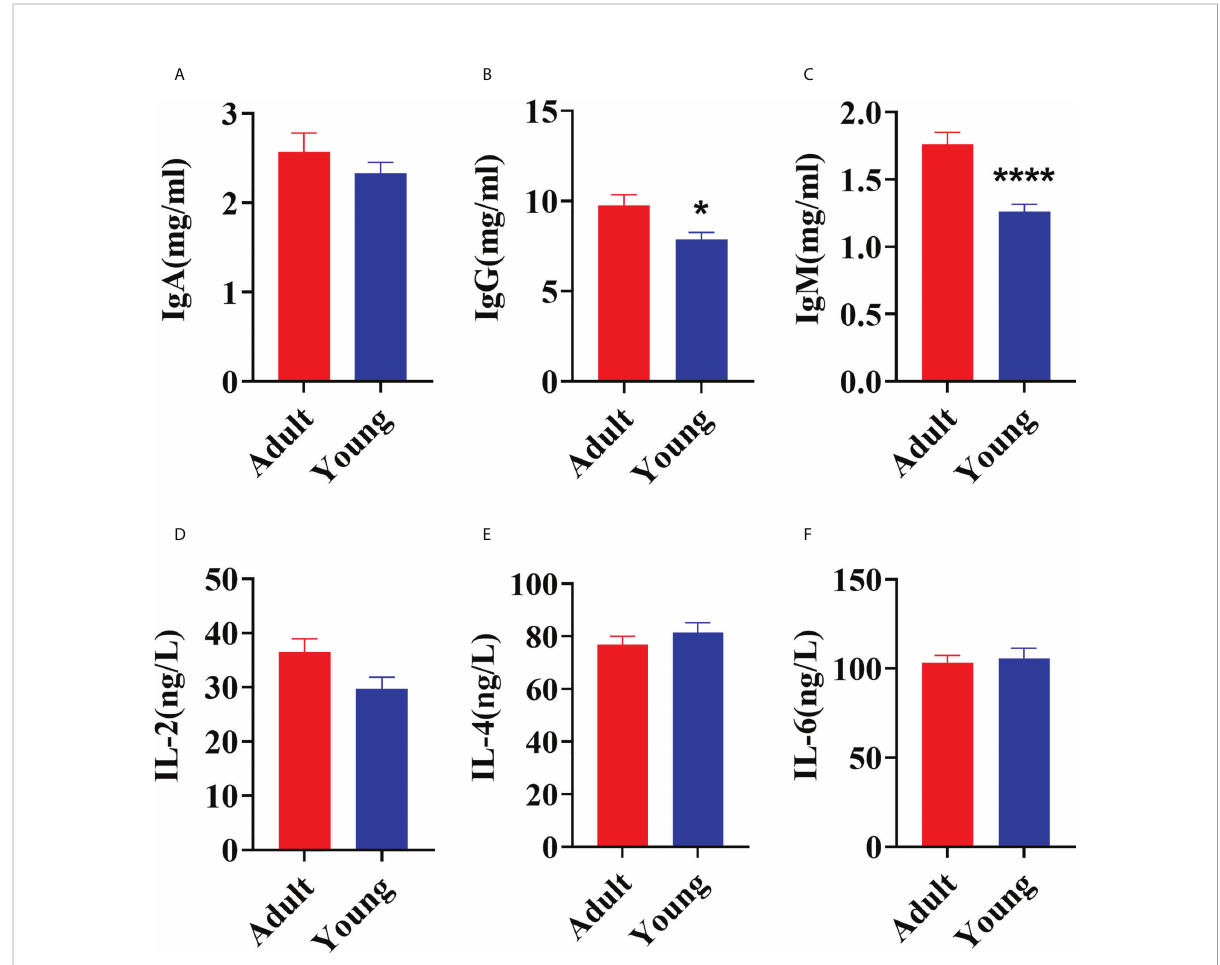
FIGURE 1 Comparison of serum immune factors concentrations between young (30 ± 2 d) and adult (2 yrs old) goats. (A) The concentration of IgA. (B) The concentration of IgG. (C) The concentration of IgM. (D) The concentration of IL-2. (E) The concentration of IL-4. (F) The concentration of IL-6. The data were analyzed with unpaired t tests, and the data were expressed as mean ± SEM. *P < 0.05 was statistically signi fi cance. ****P < 0.0001 was the extremely signi fi